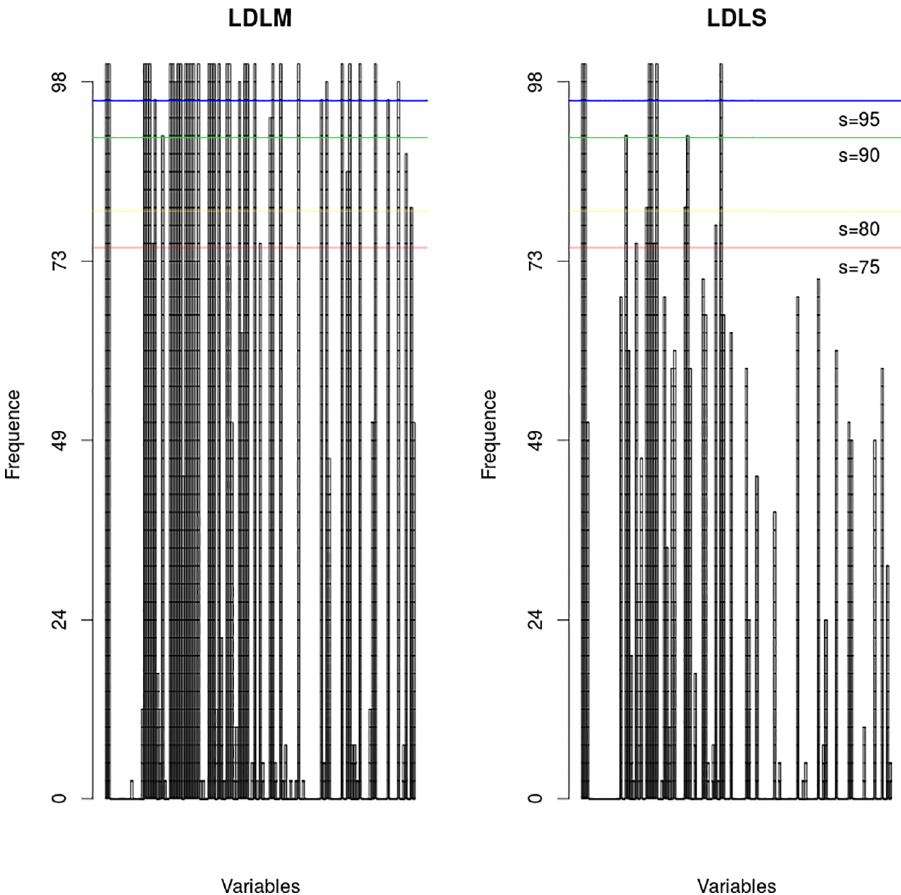
Fig 2. Frequent variables. The x-axis shows the variablesincluding the interactions, and the y-axis shows the percentage of presenceof the variables. The left figure corresponds to the LDLM strategy and the right figure corresponds to LDLS strategy. Each vertical band representsone